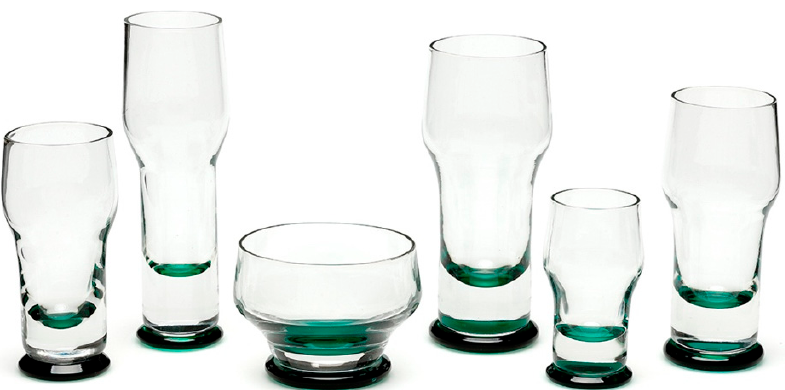
Figure 2. Luna , Maria Helena Matos, Fábrica Escola Irmãos Stephens (F.E.I.S), 1969. Photo credit: photographer Jorge Soares. Arquivo do Museu do Vidro—Câmara Municipal da Marinha Grande. Private collection of Pedro Moura Carvalho.